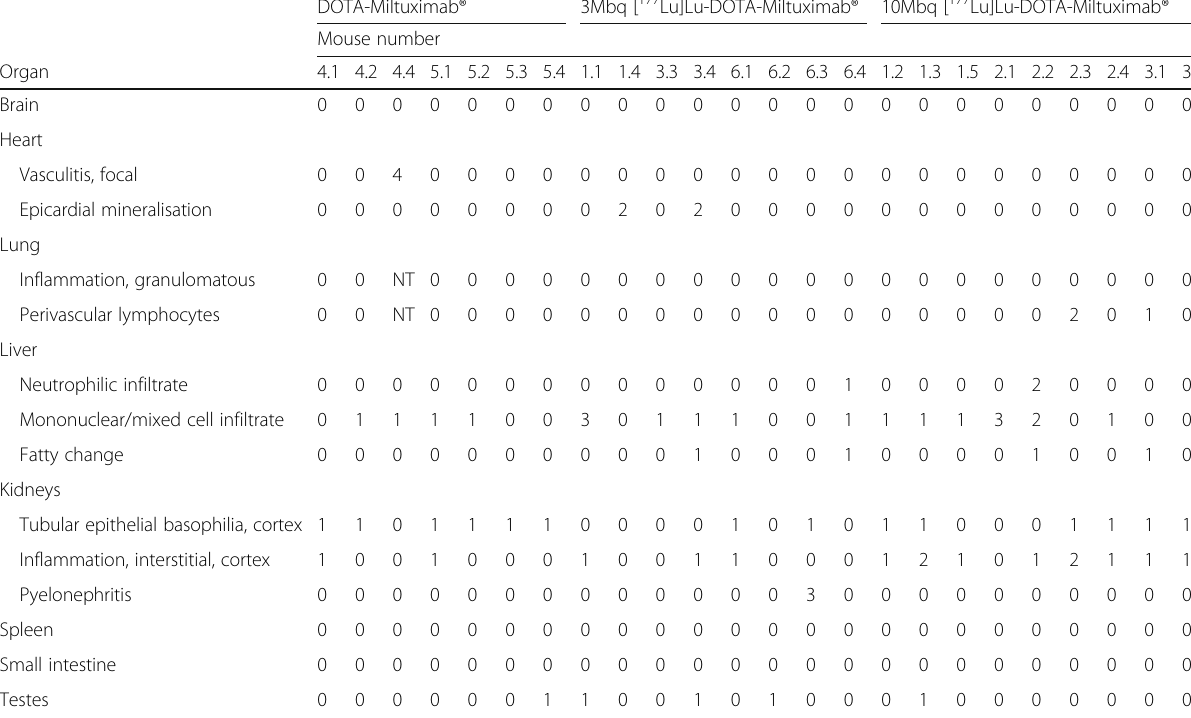
Table 2 Histopathological assessment of mice treated with DOTA_Miltuximab®, 3Mbq [177Lu]Lu-DOTA-Miltuximab® or 10Mbq [177Lu]Lu-DOTA-Miltuximab®